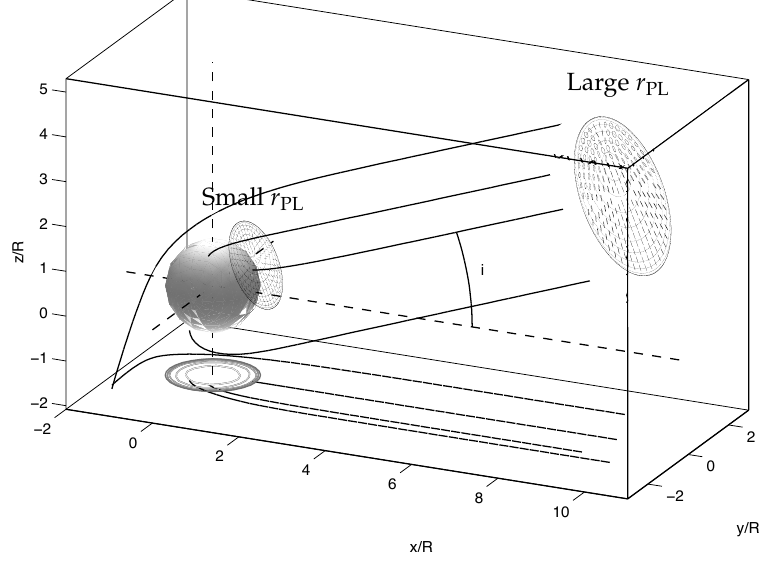
Figure 1. Radiation leaving the surface of a neutron star follows geodesics so that the bundle of rays that reaches the distant observer is approximately cylindrical. The three-dimensional coordinates ( x , y , z ) are given in terms of the radius of the neutron star ( R ). If the polarization-limiting radius is small, the final polarization will reflect the magnetic field structure near to the star where the bundle covers a large fraction of hemisphere so the field structure varies a lot over the bundle at this point, and the final polarization will also vary a lot over the image. On the other hand, if the polarization-limiting radius is large, the field structure over the ray bundle is simpler, and the polarization direction will not vary much over the image. Since the magnetic field is assumed to be that of a dipole (aligned with the z -axis), it has axial symmetry and different images will be distinguishable by the observer’s magnetic inclination angle i . Adapted from